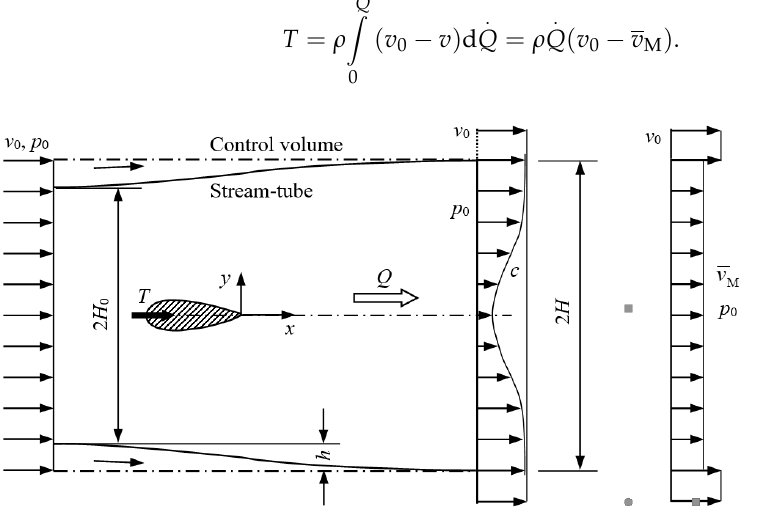
Figure 1. Control volume commonly used in aerodynamics for determining the drag force exerted on the aerofoil.